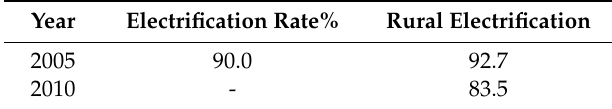
Table 3. Electrification rate and rural electrification in Syria